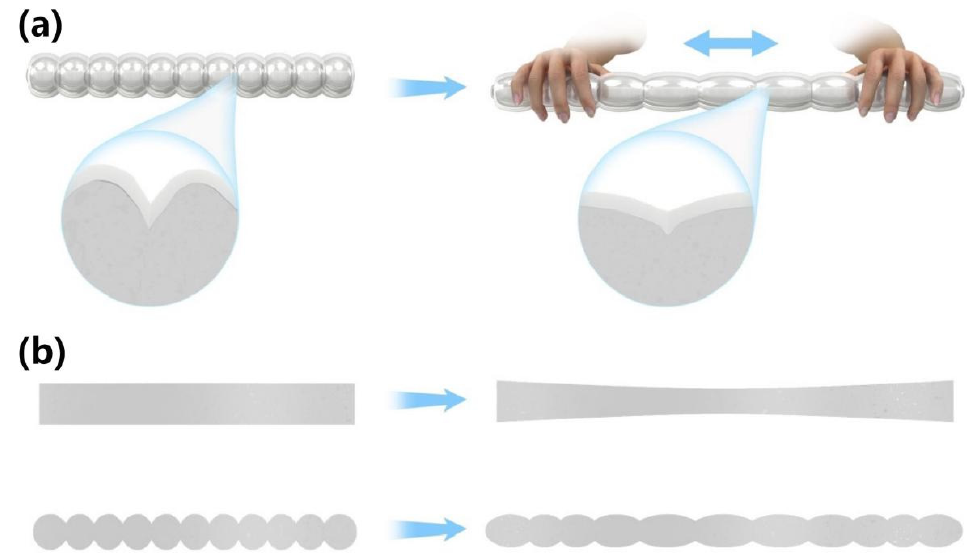
Figure 4. ( a ) Structure diagram of bunch conductive network with equiwall thickness and elastic matrix. ( b ) Schematic diagram of structural changes of equiwall-thickness bunch conductive network and ordinary cylindrical conductive network.